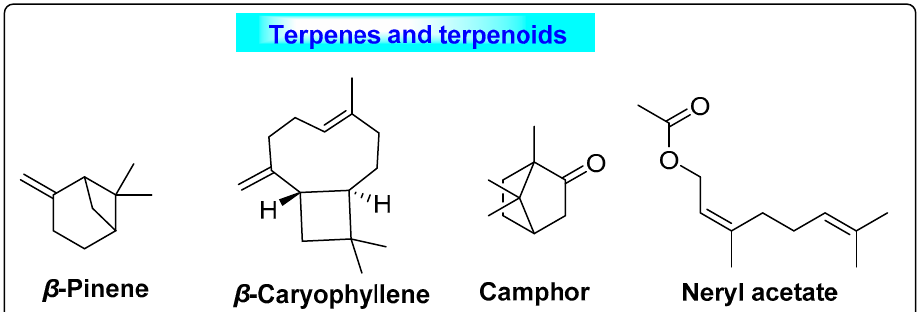
Figure 17. Terpenes and terpenoids of Trigonella foenum-graecum that suppress cyst formation.